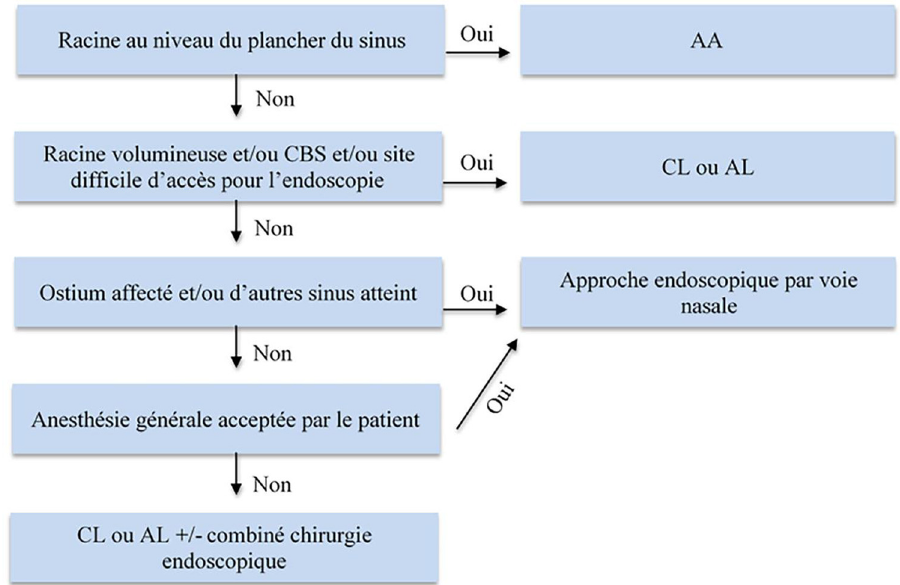
Fig 8. Decision tree on treatment approaches for removing a root in the maxillary sinus. AA: alveolar approach; CL: Caldwell-Luc; LA: lateral